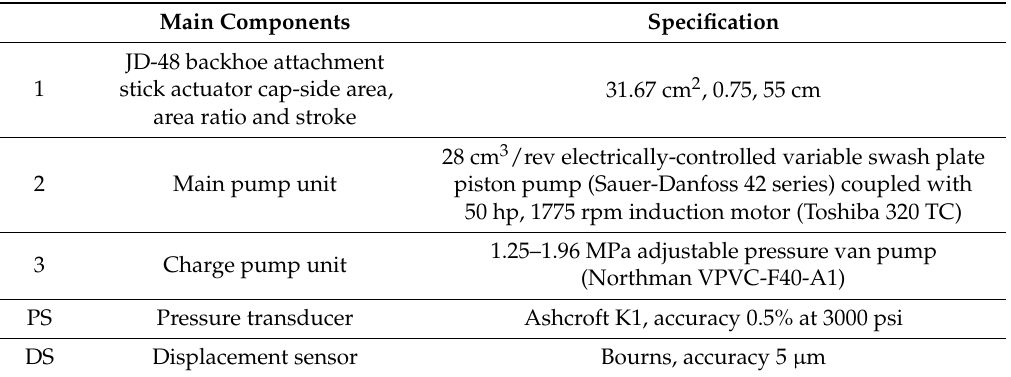
Table 1. Experimental test rig specifications.